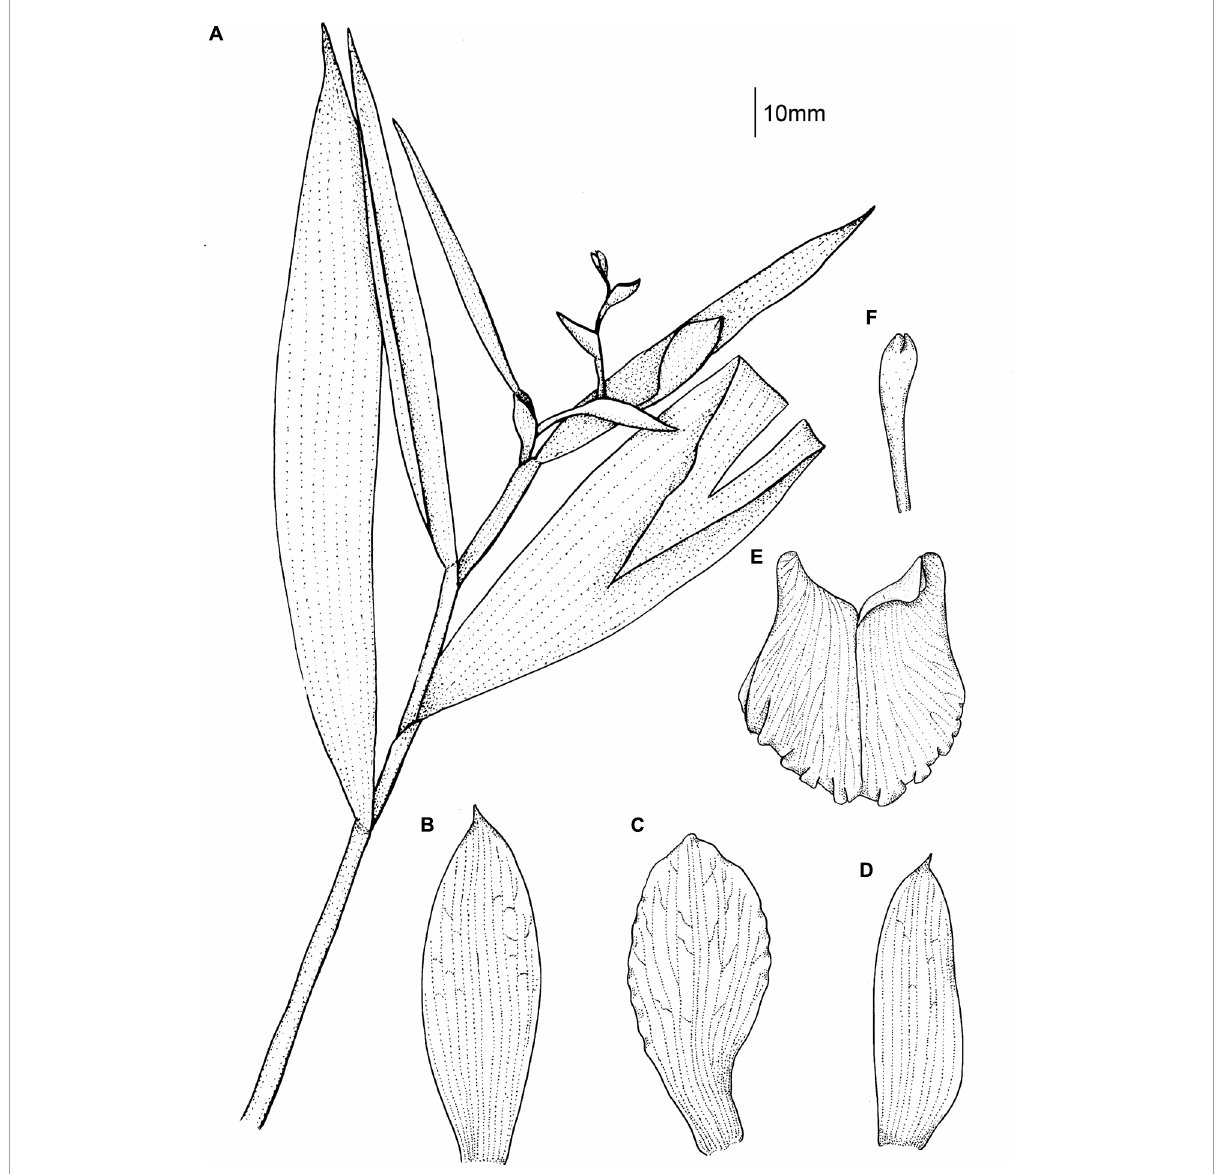
FIGURE10 Sobralia gambitana Baranow, Szlach. & Kindlmann (A) apical part of stem with inflorescence, (B) dorsal sepal, (C) petal, (D) lateral sepal, (E) lip, and (F) gynostemium, side view (drawn by P. Baranow from the holotype).